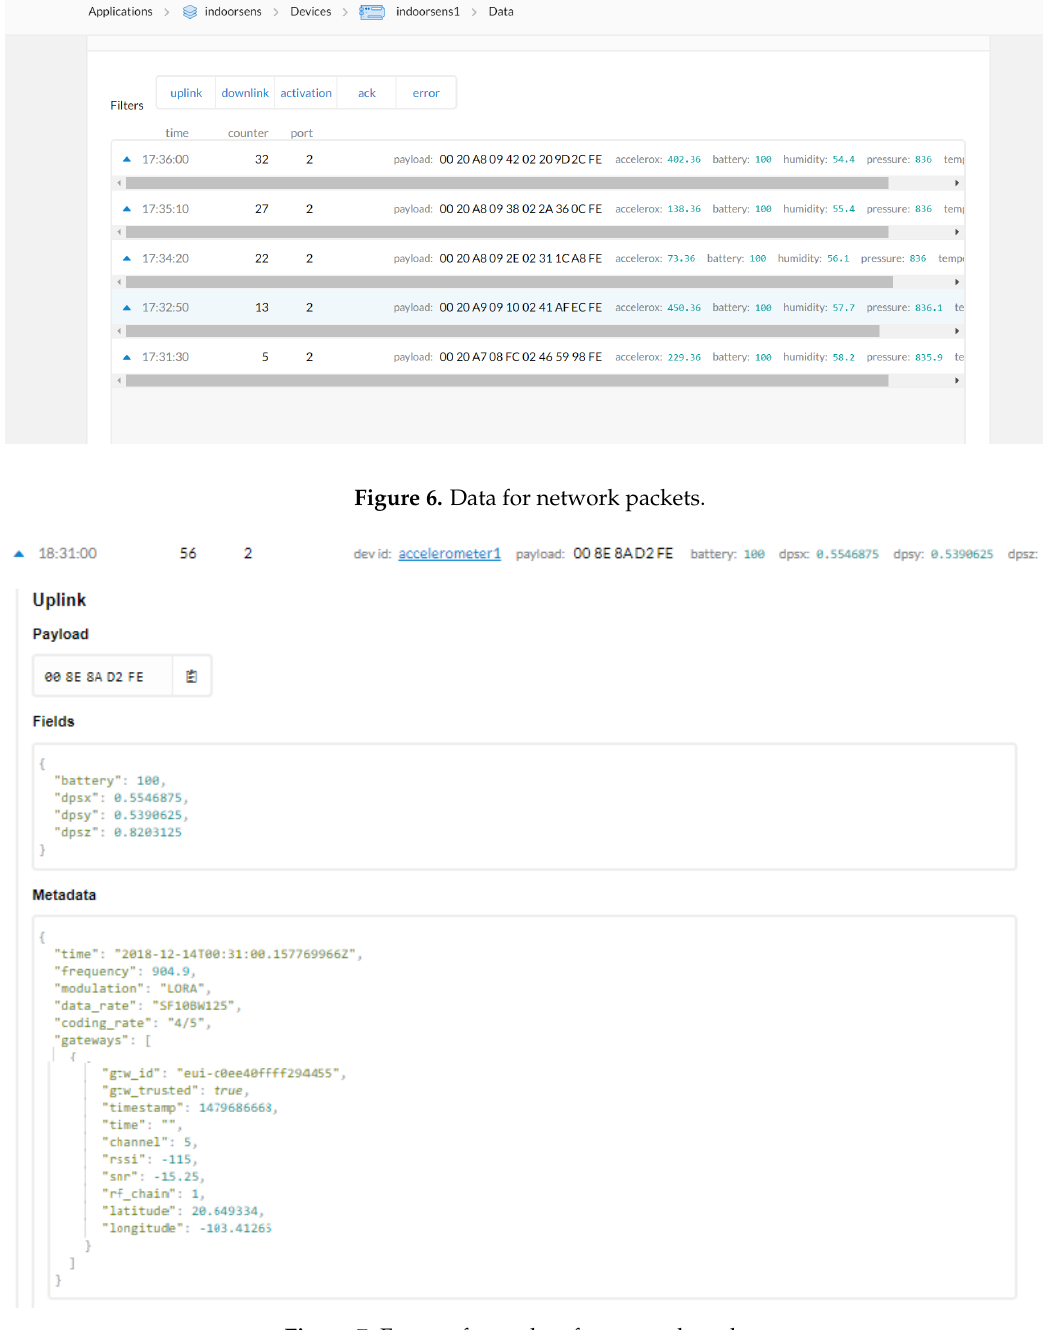
Figure 7. Frame of metadata for network